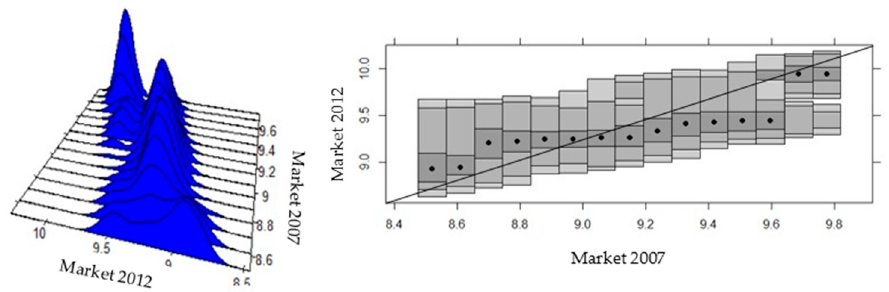
Figure 10. Intra-distribution dynamics of provincial productivity in the market service subsector, 2007–2012. Source: Own elaboration based on the Regional Accounts of the BCE [46]; ENEMDU surveys from the INEC [47] (several years) and stacked conditional density plot (SCD) in R.